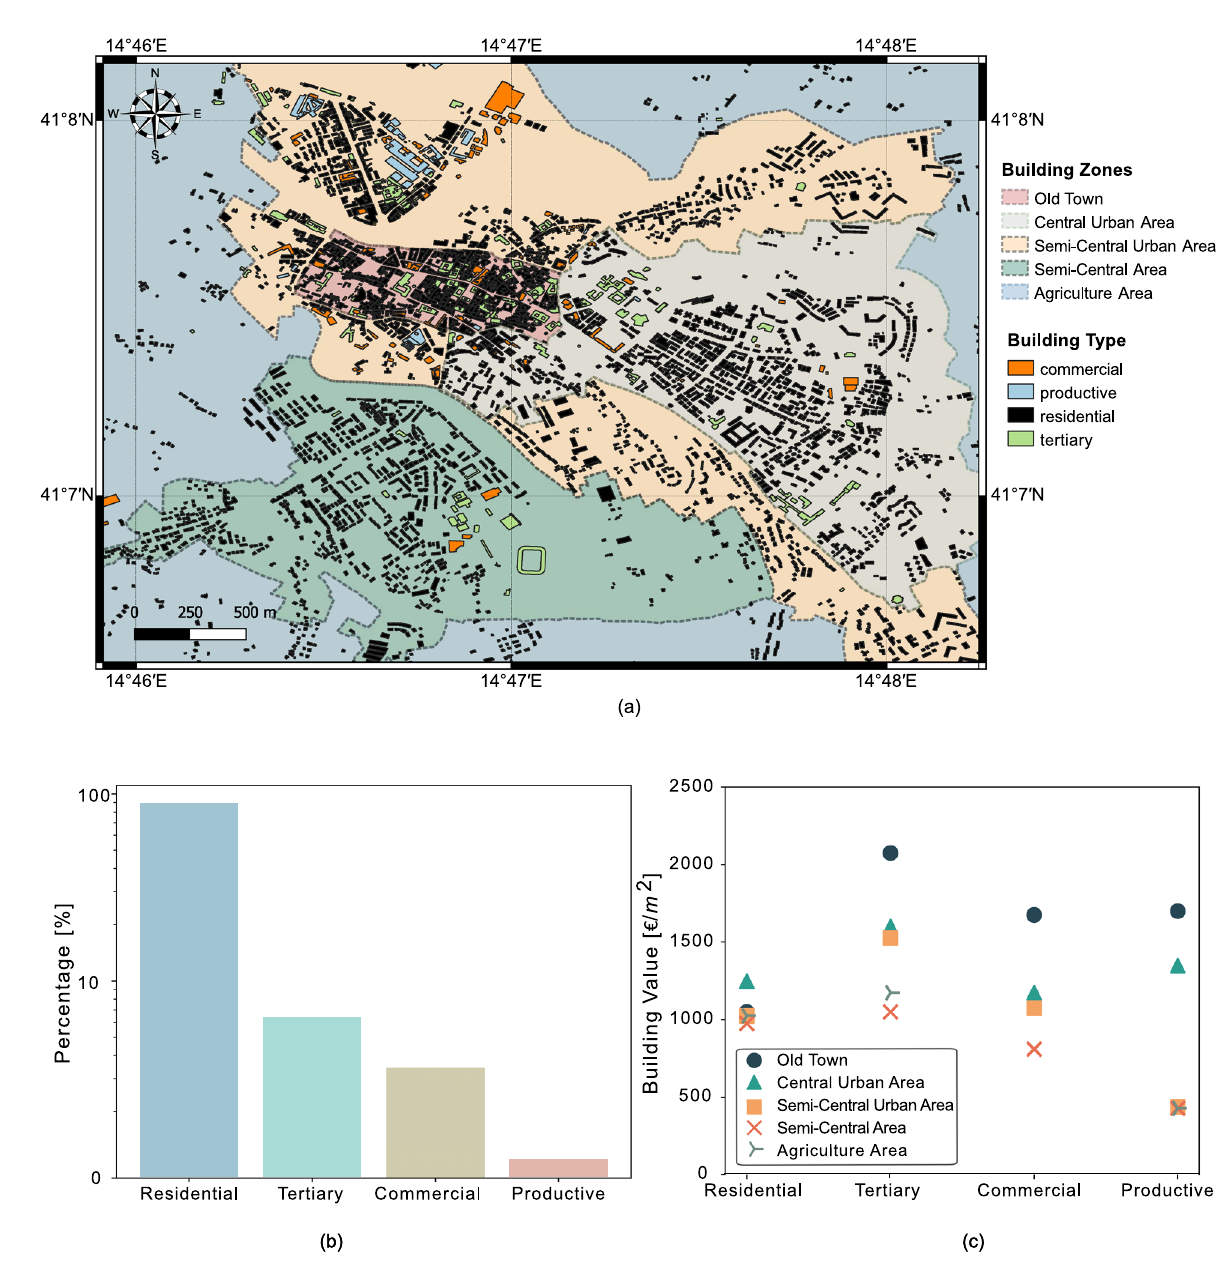
Figure 4. Exposure model: ( a ) building footprints of the Benevento region classified in four categories: commercial (orange); productive (blue); residential (black); tertiary (green); Territorial zones categorised as per Italian Revenue Agency 18 : (1) old town (pink); (2) central urban area (off white); (3) semi-central urban area (ivory); (4) semi-central area (dark green); (5) agriculture area (blue); This figure is created with QGIS version 3.18.2 (https:// www. qgis. org/); ( b ) proportion of buildings in each category in the Benevento region: residential (blue); tertiary (green); commercial (yellow); productive (red); ( c ) per square meter value of each building typology based on different territorial zones: old town (circle); central urban area (triangle); semi-central urban area (cross); agriculture area (tri